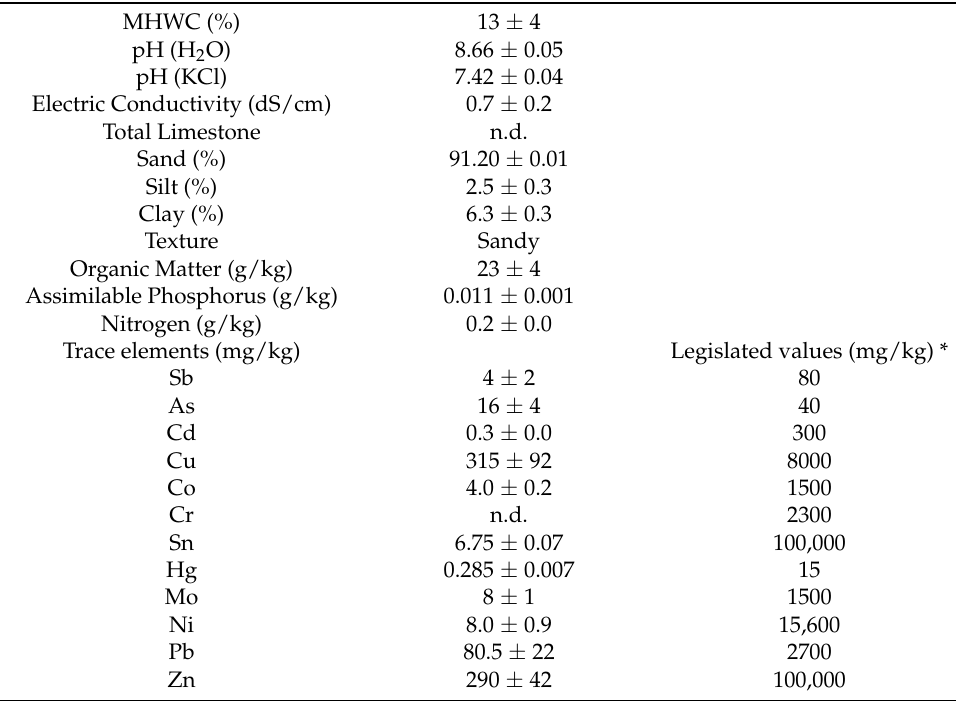
Table 1. Soil basic characterization (mean ± standard deviation) n =